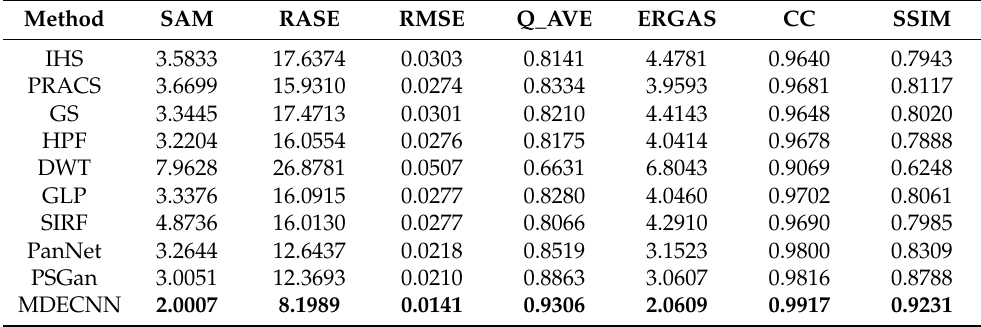
Table 3. Quantitative assessment of the WorldView-3 dataset is shown in Figure 8. The best perfor- mance is shown in